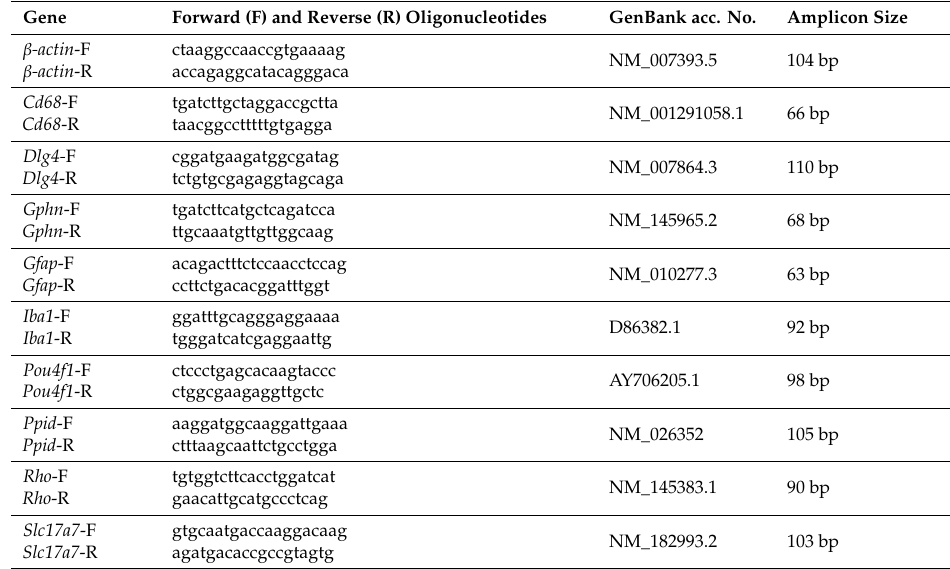
Table 3. Sequences of oligonucleotides. The listed oligonucleotide pairs were used in quantitative real-time PCR experiments, while β -actin and Cyclophilin (Ppid) served as housekeeping genes. The predicted amplicon sizes are given. Abbreviations: F = forward, R = reverse, acc. no. = accession number, bp = base